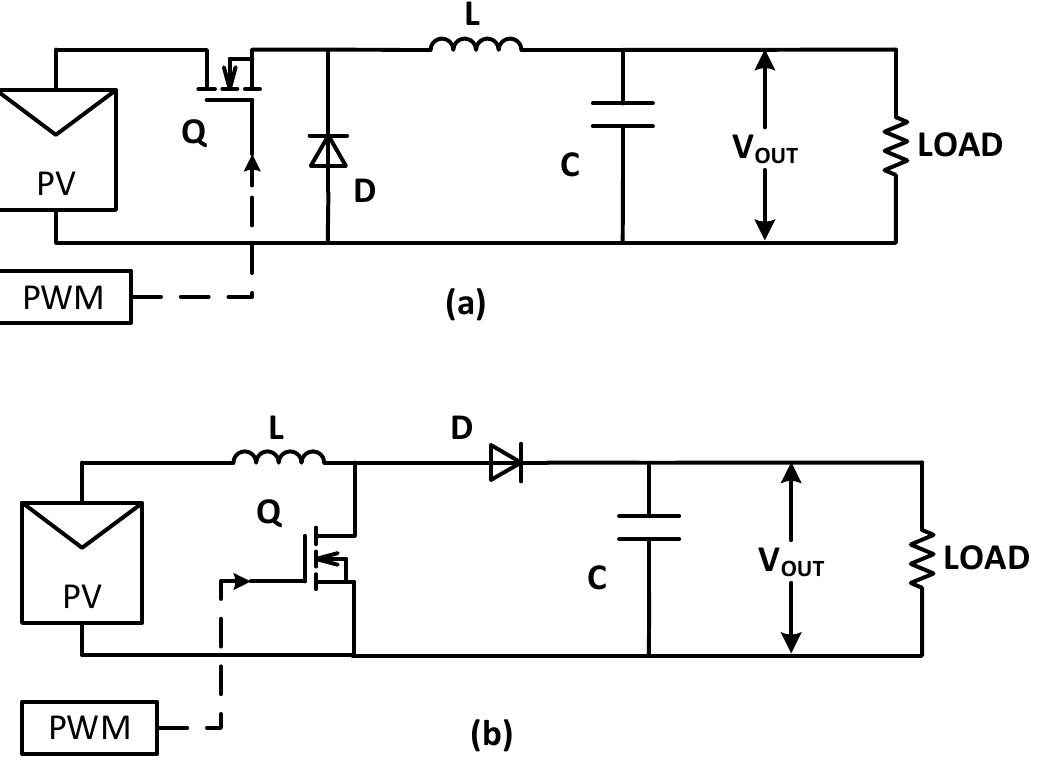
Figure 5. The general topology of buck ( a ) and boost ( b ) PV fed converters.